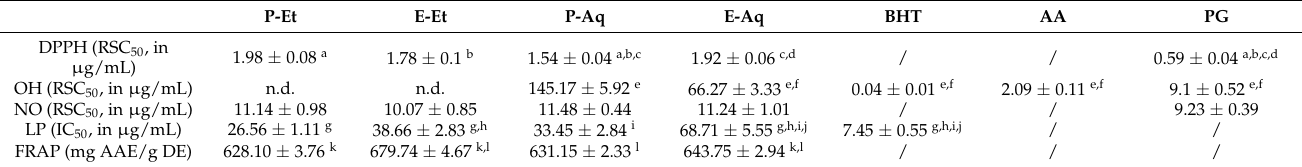
Table 4. The results of antioxidant potential testing.